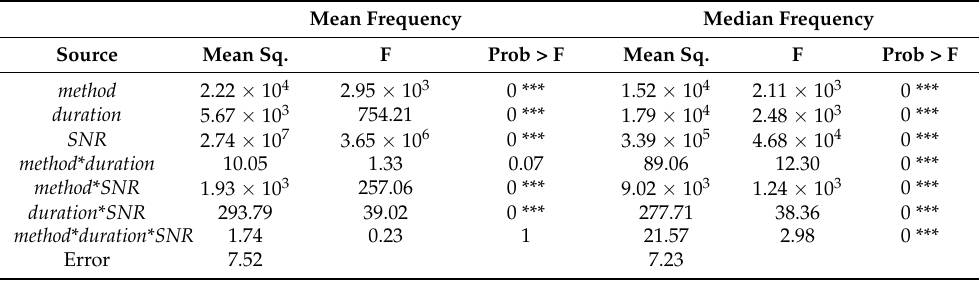
Table 1. Three-way ANOVA tests were performed to investigate the effects of the three factors on both Mean (MNF) and Median frequency (MDF). The three factors used were method (Welch and orders of Burg), duration ( T varying from 250 to 2000 ms), and SNR (from 5 to 20 dB). The two-way and three-way interaction effects are shown starting from the 4th row of the table up to the 7th one, respectively. The significance levels were set at: * p < 0.05, ** p < 0.01, *** p < 0.001. Mean square, F-statistic, and p -value are provided. All the values less than 2 × 10 − 16 were indicated as 0, with the corresponding significance indicated by *** p <